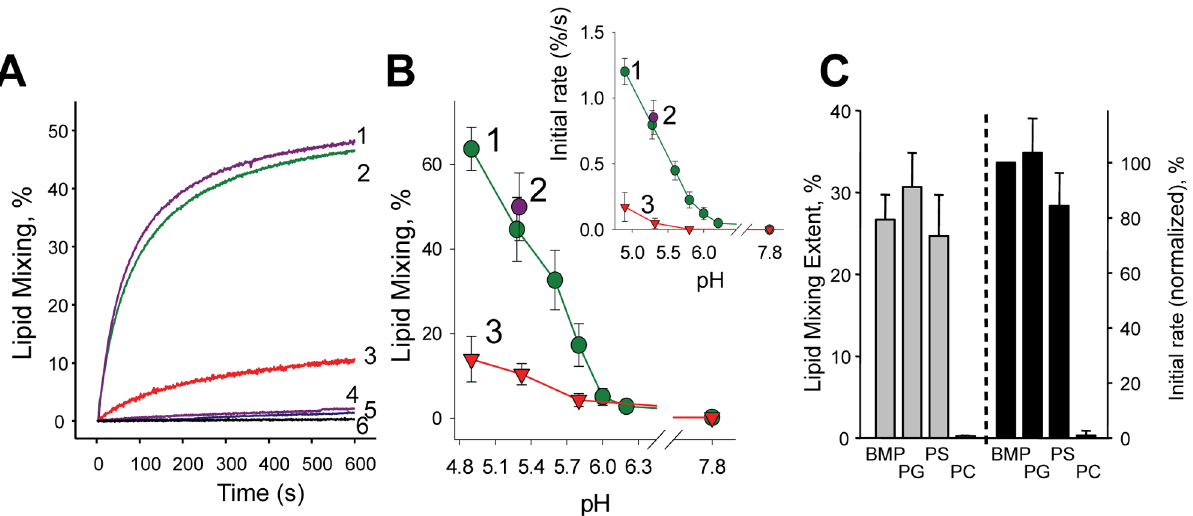
Figure 2. The dependence of DEN fusion to liposomes on anionic lipids. A. Lipid mixing between DiD-labeled DEN virions and liposomes of LEM-Chol (1); LEM (2); and PM (3) compositions (pH 5.3, 37 u ) assayed as DiD dequenching. 4 & 5 –LEM liposomes with DEN virions inactivated by pre- incubation at pH 4.5 or by DEPC. 6 –DEN and LEM liposomes at pH 7.8. B. The extent of the lipid mixing between DEN and LEM- (1); LEM-Chol- (2) and PM- (3) liposomes at different pH observed 10 min after acidification. Insert –initial rates of lipid mixing between DEN and LEM- (1); LEM-Chol- (2) and PM - (3) liposomes at different pH. C. Fusion between DEN virions and liposomes formed of mixtures of 70 mol % PC and 30 mol % of either BMP or PG or PS or liposomes formed of PC was measured at pH 5.3 and quantified as initial rates of lipid mixing (black bars, BMP-containing liposomes (‘‘BMP’’) taken as 100%) and the extents of the lipid mixing at t=10 min (grey bars). The data in B and C are presented as means + / 2 s.d, n $ 3.